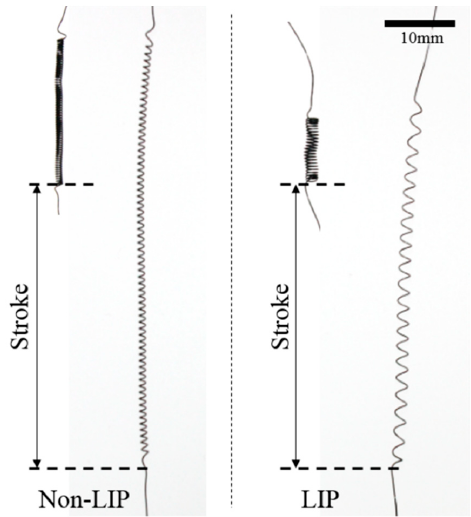
Figure 4. Fabricated SMA coil spring actuators; non-LIP SMA coil spring actuator (left).